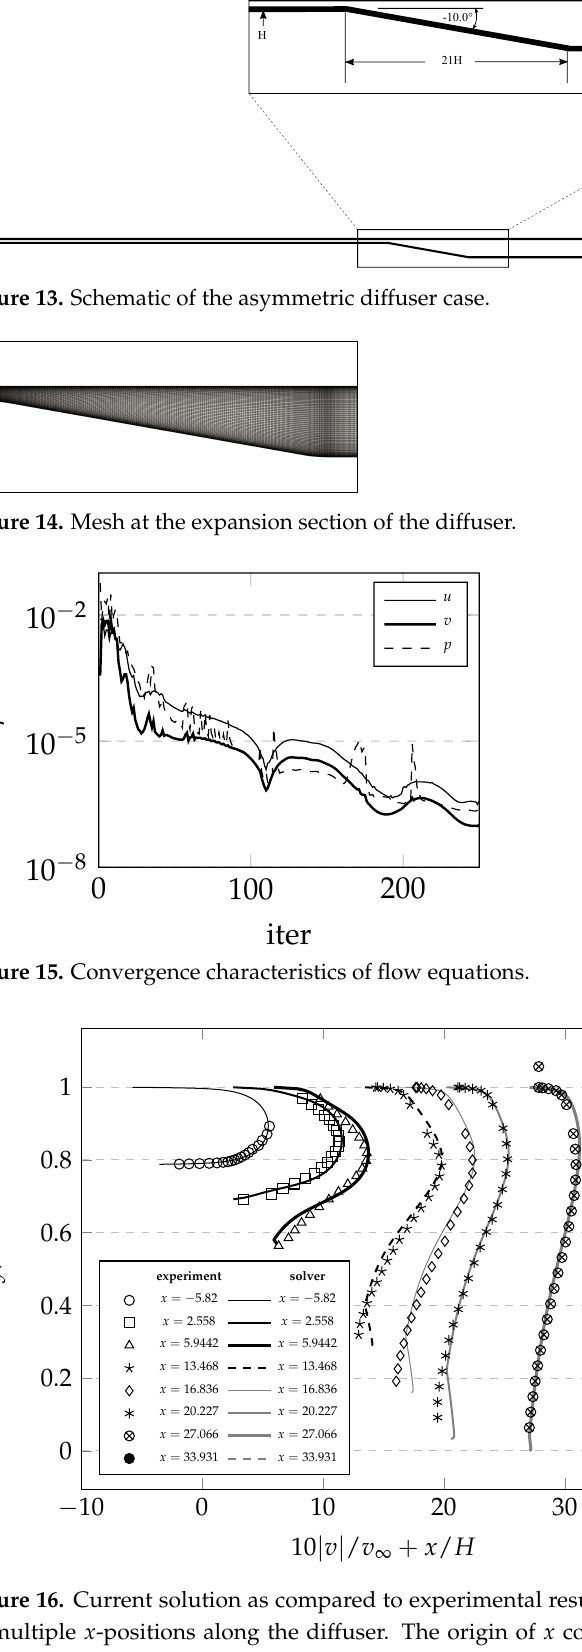
expansion section, as shown in Figure expansion section as shown in Figure 13